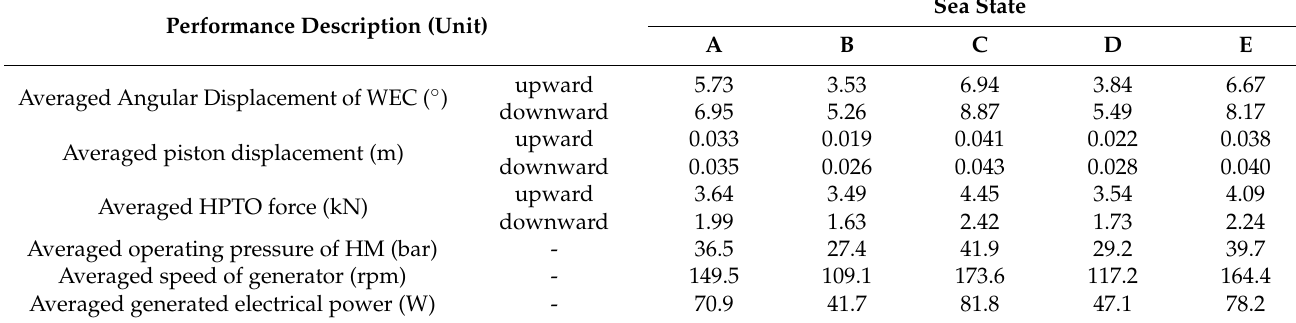
Table 5. Performance of WEC with HPTO unit in different sea